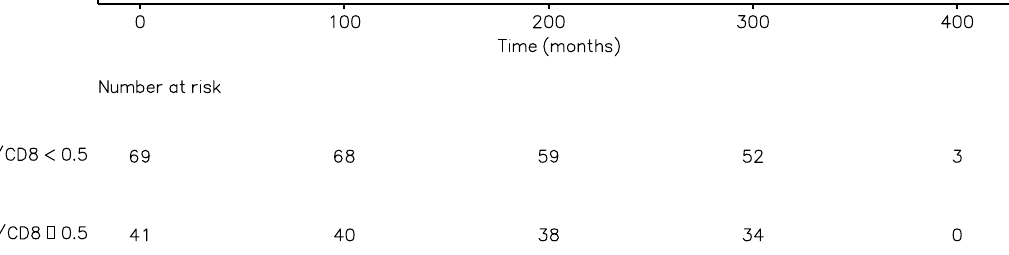
infection through unprotected heterosexual sex ( p =